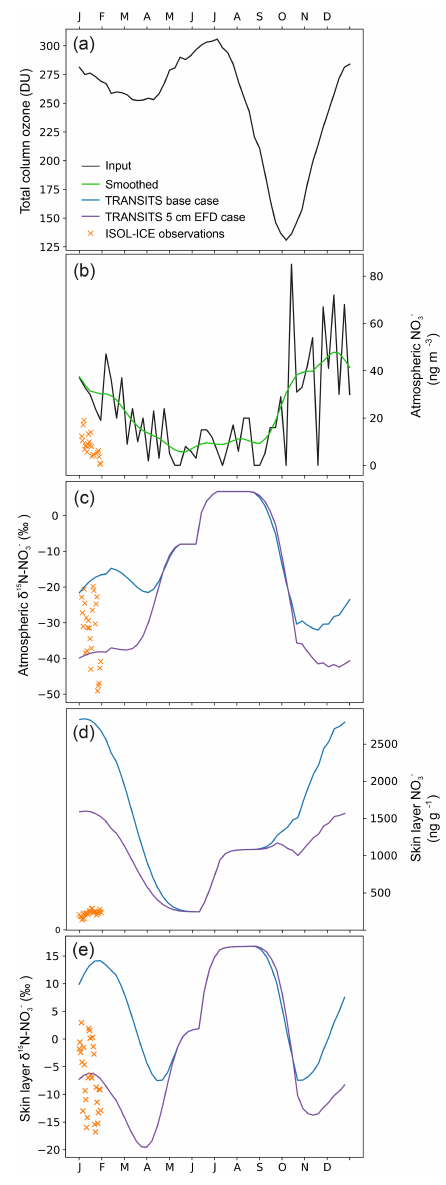
Figure 5. ISOL-ICE observations and simulated annual cycle of skin layer and atmospheric NO − mass concentration and δ 15 N- 3 NO − at Dronning Maud Land (DML) from the base case and 3 5cm EFD case TRANSITS model simulations for January 2017. (a) Total column ozone: NIWA Bodeker combined dataset ver- sion 3.3 at DML averaged from 2000 to 2016 (http://www. bodekerscientific.com/data/total-column-ozone, last access: 15 Jan- uary 2019). (b) Atmospheric NO − mass concentrations are obser- 3 vations from Kohnen Station (Weller and Wagenbach, 2007) that are used as input into the model. ISOL-ICE observations and TRAN- SITS simulations of (c) atmospheric δ 15 N-NO − , (d) skin layer 3 NO − mass concentration, and (e) skin layer δ 15 N-NO − 3 3